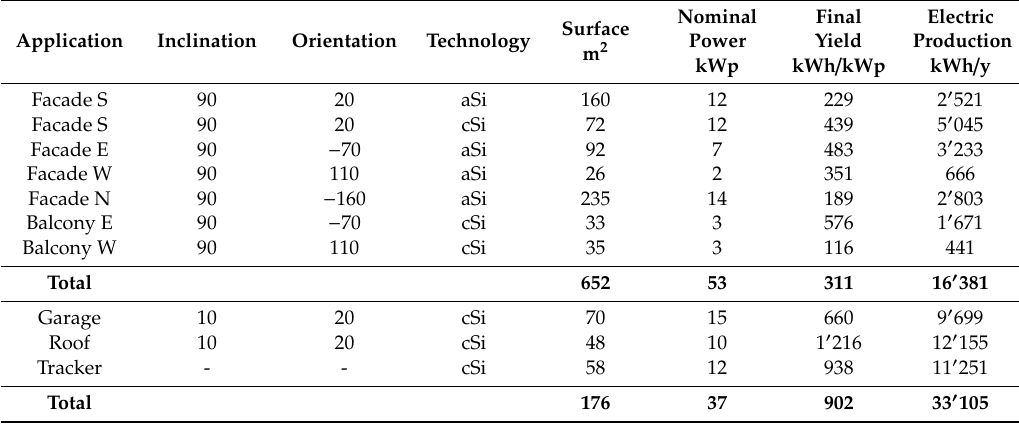
Figure 1. East façade of Palazzo Positivo (source: SUPSI, University of Applied Sciences and Arts of Southern Switzerland). Table 1. Definition of BIPV and BAPV (Building Applied Photovoltaics)